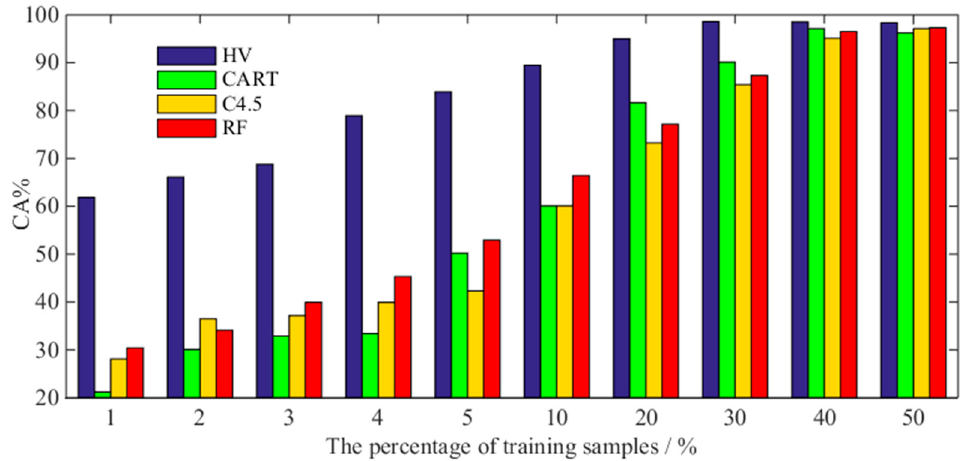
Figure 14. Classification accuracy of different ensemble classifiers under different percentages of training samples: from left to right, HV, CART, C4.5 and RF.